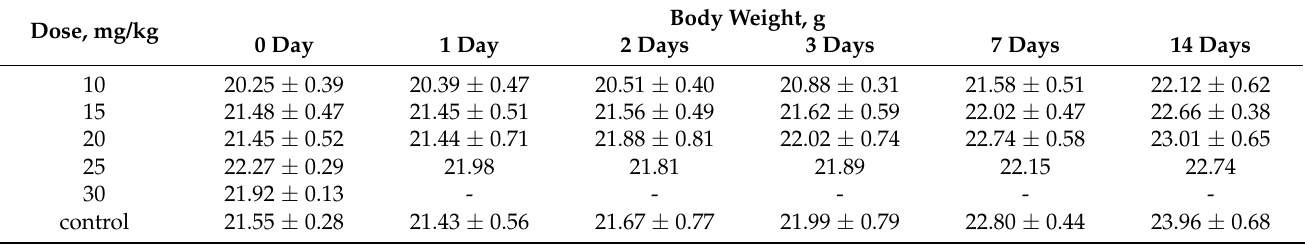
Table 6. The body weight changes of BDF 1 hybrid mice after a single intraperitoneal injection of 4e .